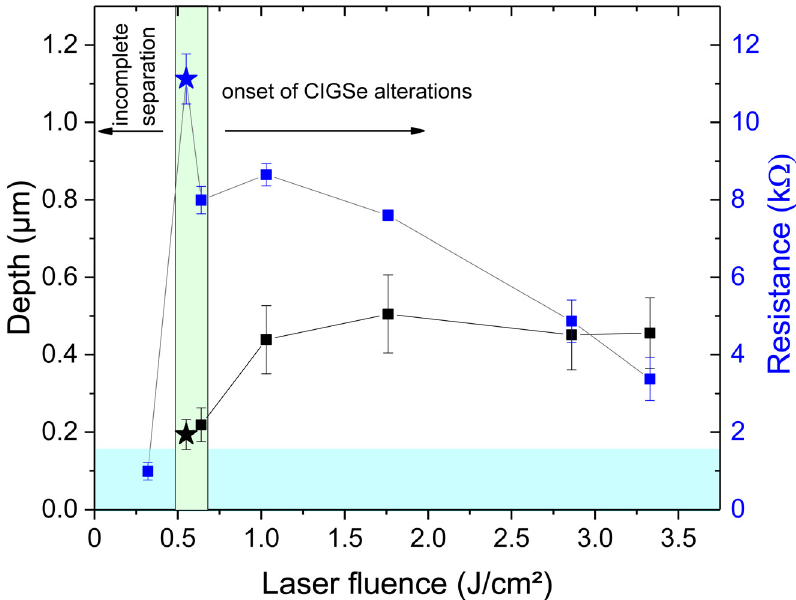
Fig. 4. Iso-cut scribe line depth (right y-axis, black squares) and electrical resistance across the scribe line (left y -axis, blue squares) as a function of the applied laser fl uence. The range of suitable fl uences is marked by the light green area, the selected fl uence with an asterisk. The cyan area illustrates the intermediate CdS/i-ZnO/ZnO:Al window layer